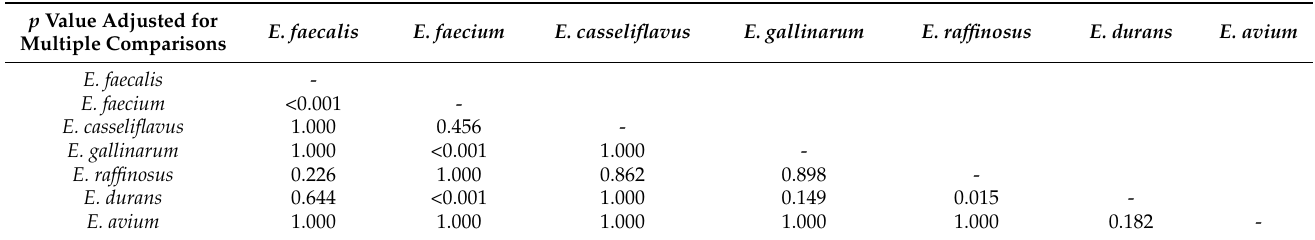
Figure 2. Comparison of MAR index among Enterococcus species. Table 7. Pairwise comparison of the MAR index of the Enterococcus species.